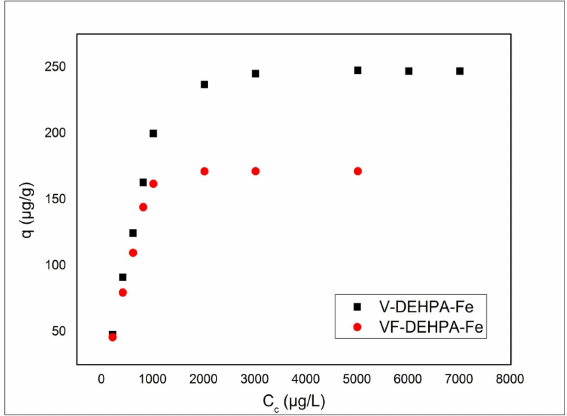
Figure 11. Effect of initial concentration of As(V) on the adsorption